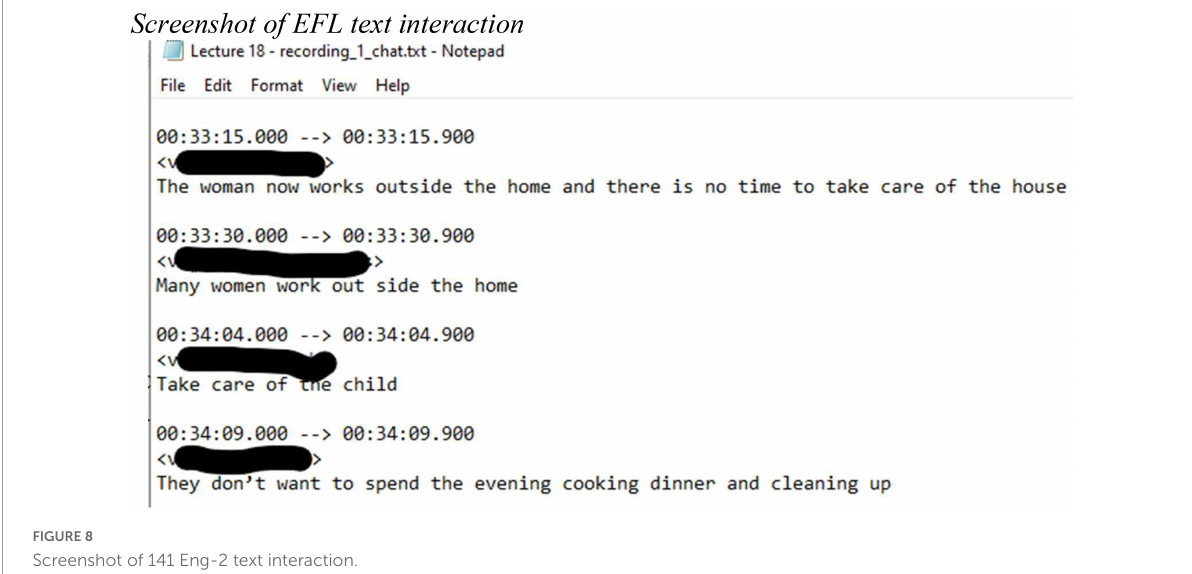
FIGURE8 Screenshot of 141 Eng-2 text interaction.